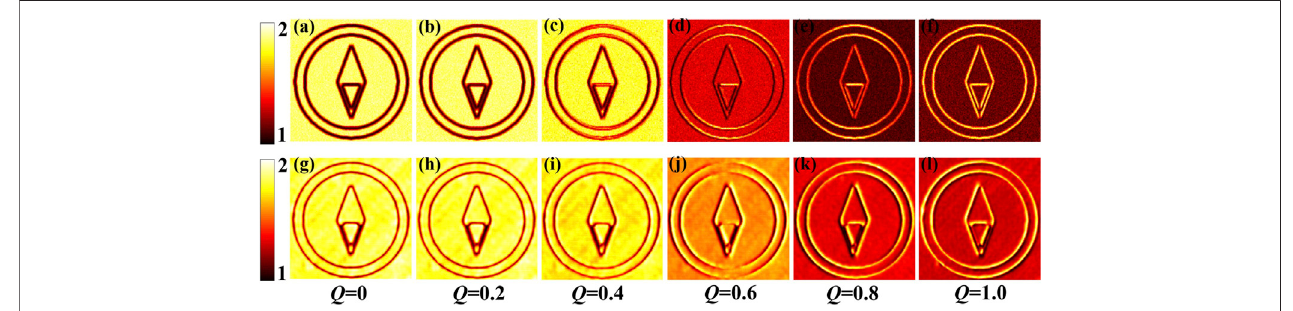
FIGURE3 | Experimental results ofthe circle phase with the integerand fractional vortex fi lters. (A – F) show the2D edge-enhanced images and the fi tted curves of some special azimuth corresponding to different Q .